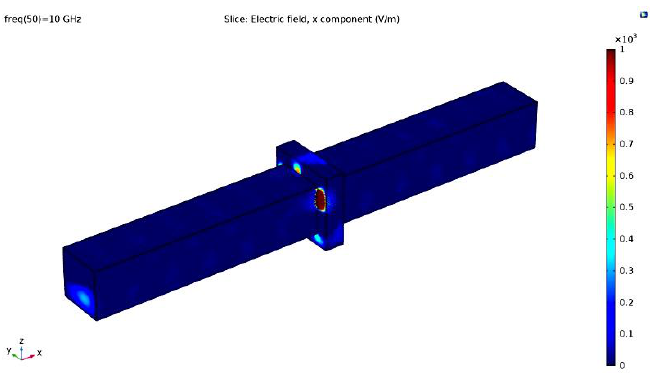
Figure 10. Simulation of Electric Field Intensity through COMSOL Multiphysics.